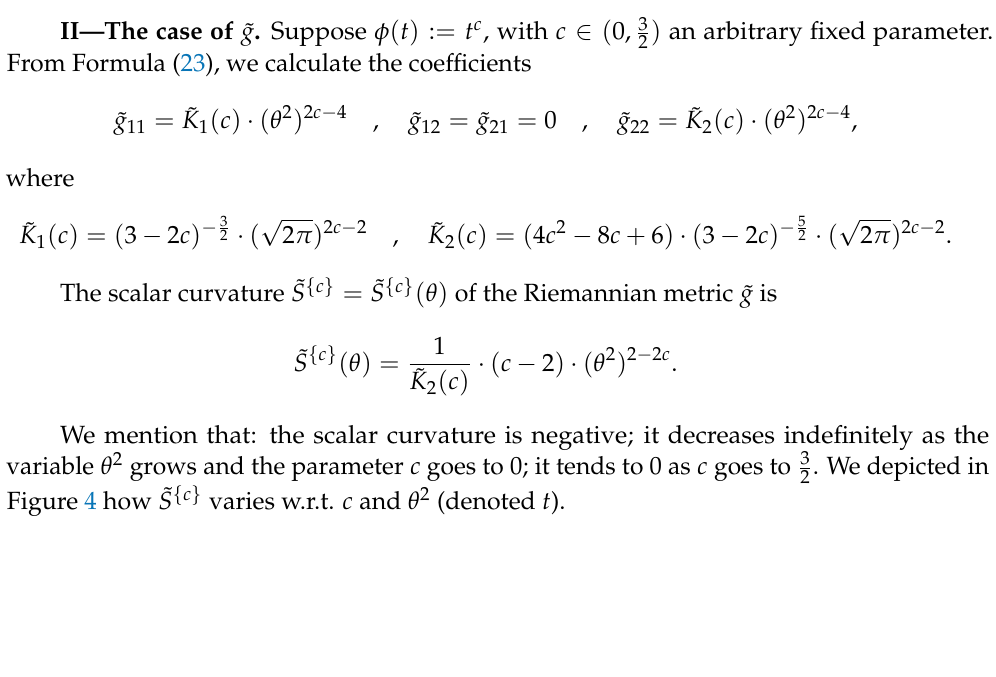
Figure 3. The variation of S { c } w.r.t. c ∈ ( 0.18,0.20 ) and θ 2 : = t